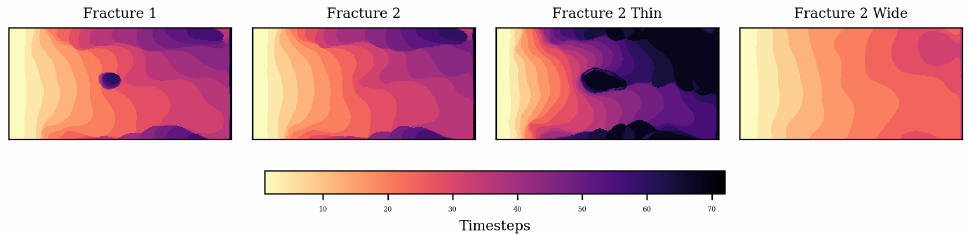
Figure 3. Overlaid CO 2 fronts spanning 72 total time steps of the lattice-Boltzmann simulation. The different roughness and shapes of our fracture domains create very different flow